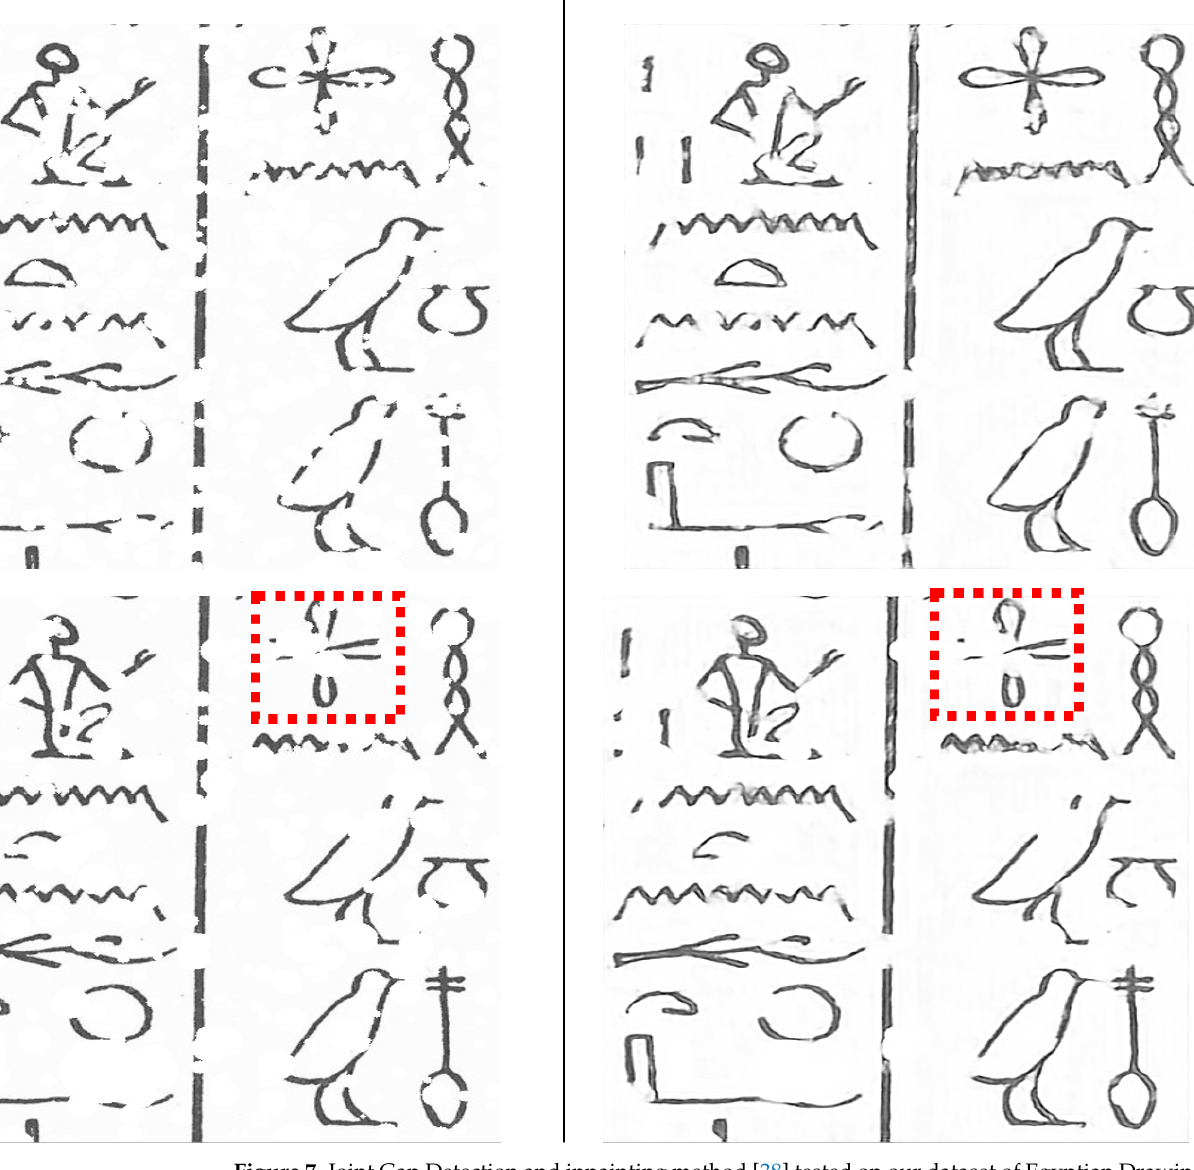
Figure 7. Joint Gap Detection and inpainting method [38] tested on our dataset of Egyptian Drawings. The left column shows the Egyptian signs with gaps of different sizes. The middle column is the predicted image with gaps completed. The right column is the ground truth image. The red dashed lines highlight the areas in which the inpainting algorithm failed to detect and fill the line